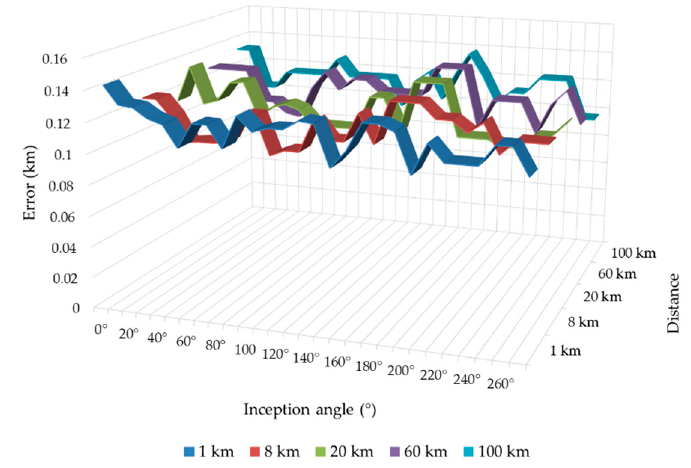
Figure 15. Location error for SLG faults with varying the soil resistivity. Figure 14. Location error for SLG faults with varying the inception angle between 0 ° and 270 ° .